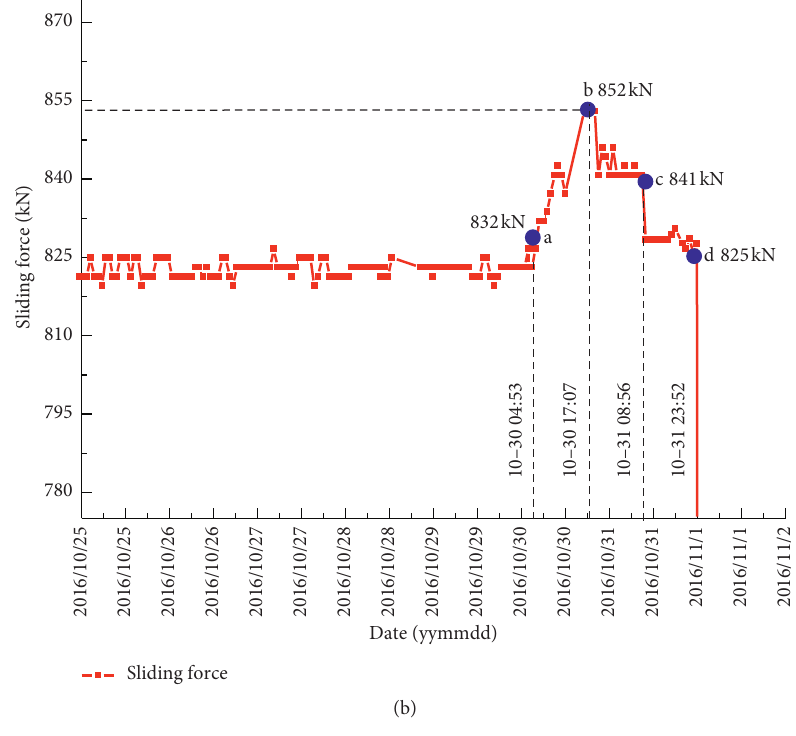
Figure 15: Monitoring curve of the sliding force (point no.